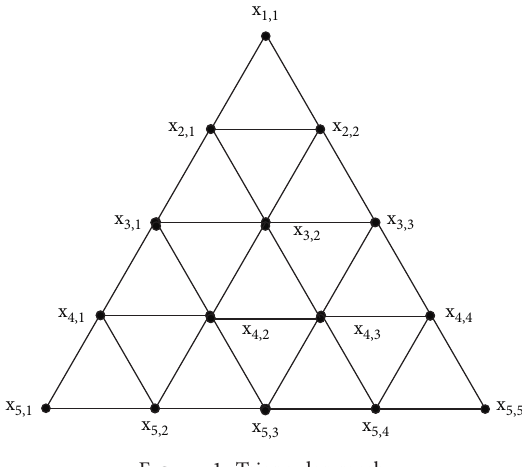
Figure 1: Triangular